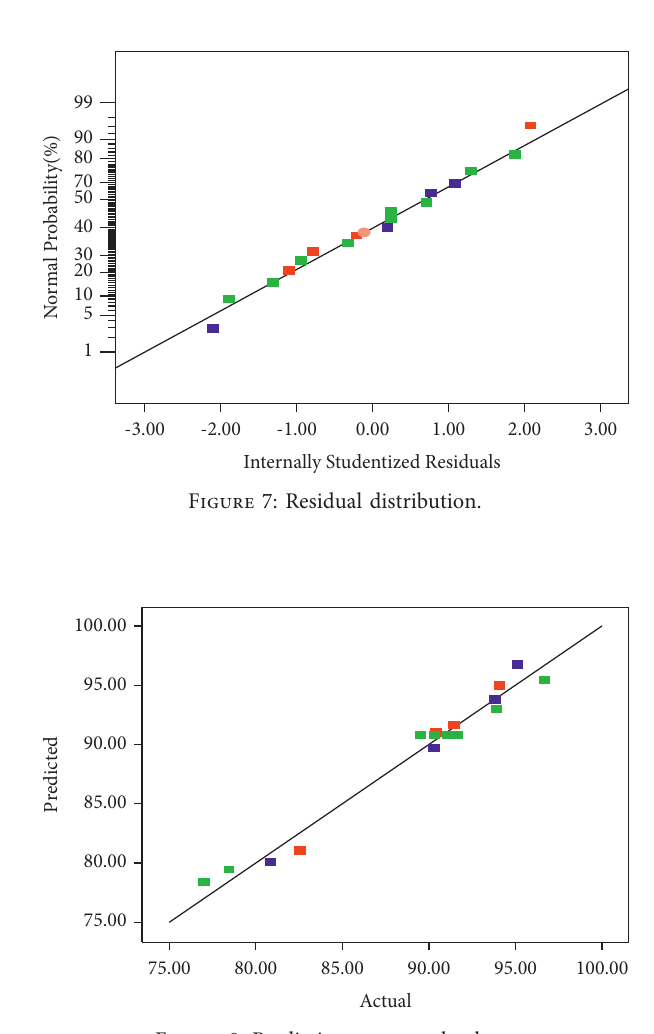
Figure 8: Predictions vs. actual